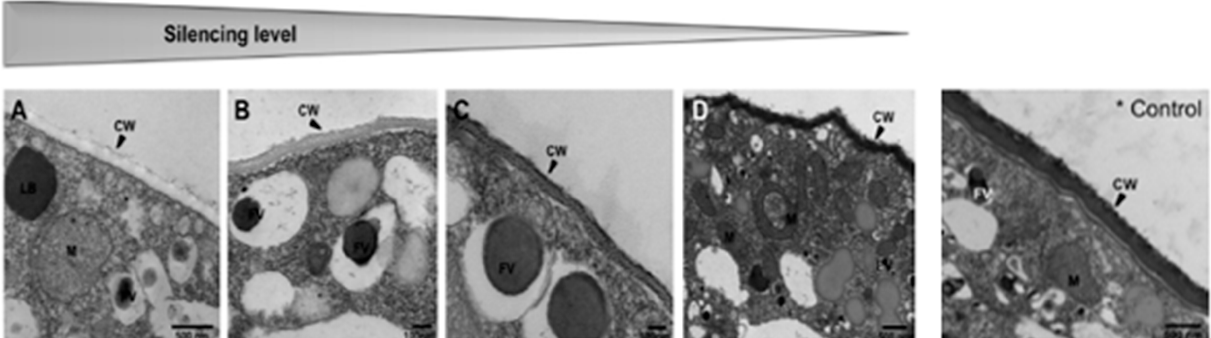
Figure 13. Effect of silencing of SpTyr gene on the cell wall of Saprolegnia parasitica [133]. Figure 13 describes the gene expression level of SpTyr-silenced lines using TEM. This method exposes an electron-dense layer in the cell wall (CW) of the sporangia of the control lines (*) and a non-silenced line ( D ). The pictures ( A – C ) show the decreased electron-dense layer in the cell wall of the sporangium with decreased levels of SpTyr-expression [132].